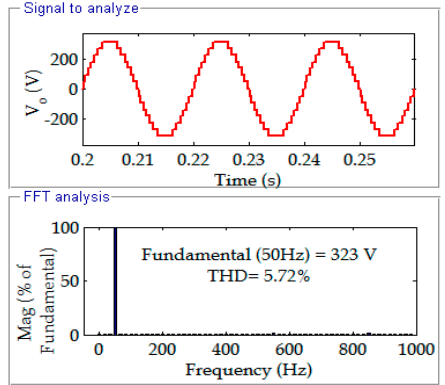
Figure 9. 63-level reduced switch multilevel inverter.